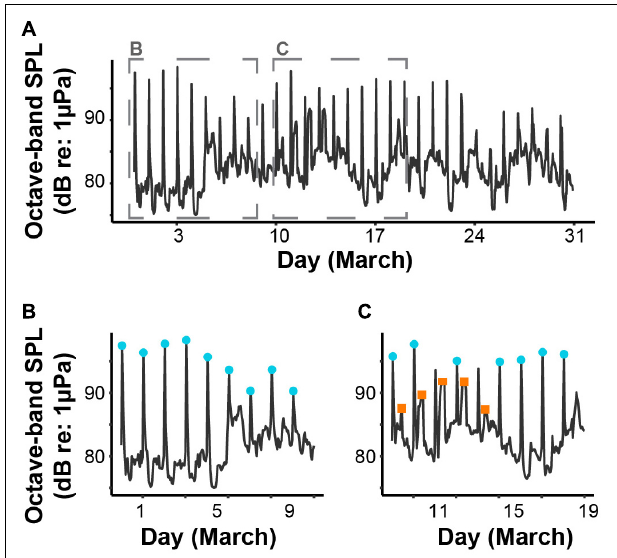
FIGURE 5 | Temporal patterns in sound levels reveal multiple sources. Periodic increase in sound levels in the 500-Hz octave band sound pressure level (A) related to presence of multiple fish choruses at a site in Florida Keys National Marine Sanctuary (FK02). This temporal resolution showed the fish chorus consisted of two fish species chorusing at slightly different intervals on some days of the month (B,C) . Cyan dots = peaks of species one chorusing, orange squares = peaks of species two